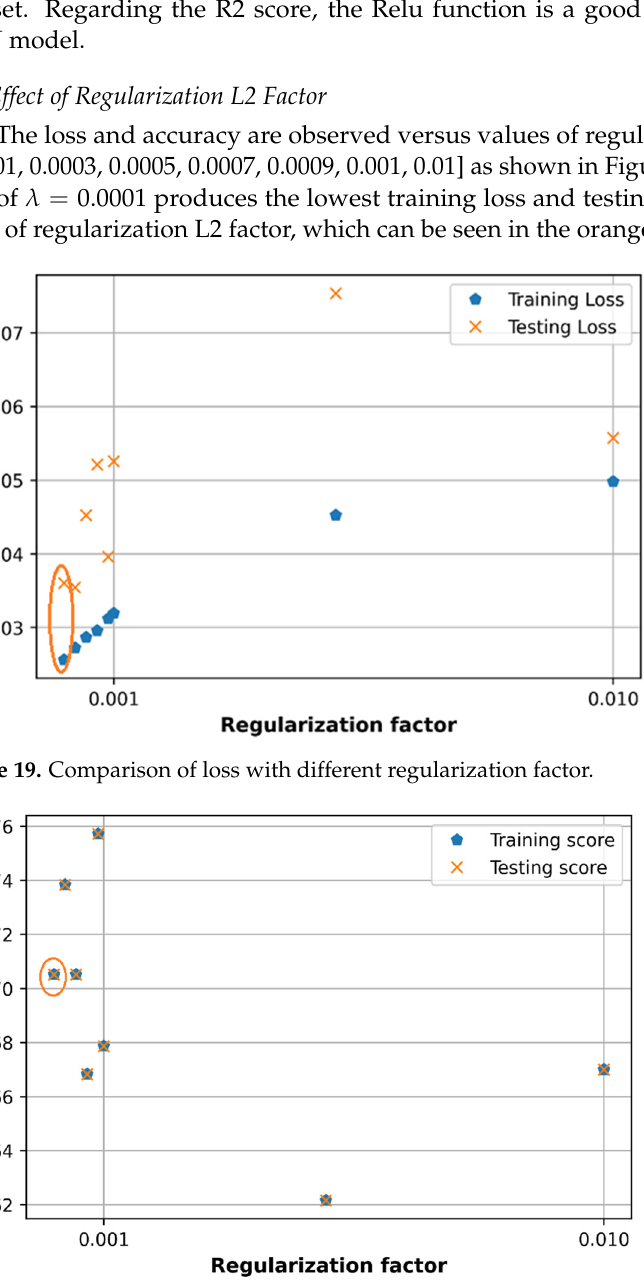
Figure 21. Comparison of loss with different the number of hidden units. The optimal number of neurons in each hidden layer when tuning separately (41 neurons) is different from the random search method result (58 neurons each layer). How- ever, the size of the DNN model in the random search method (in Table 3) produces a slightly lower loss (0.0023) and higher R2 score (0.77) compared to the model size tuned manually in this subsection.